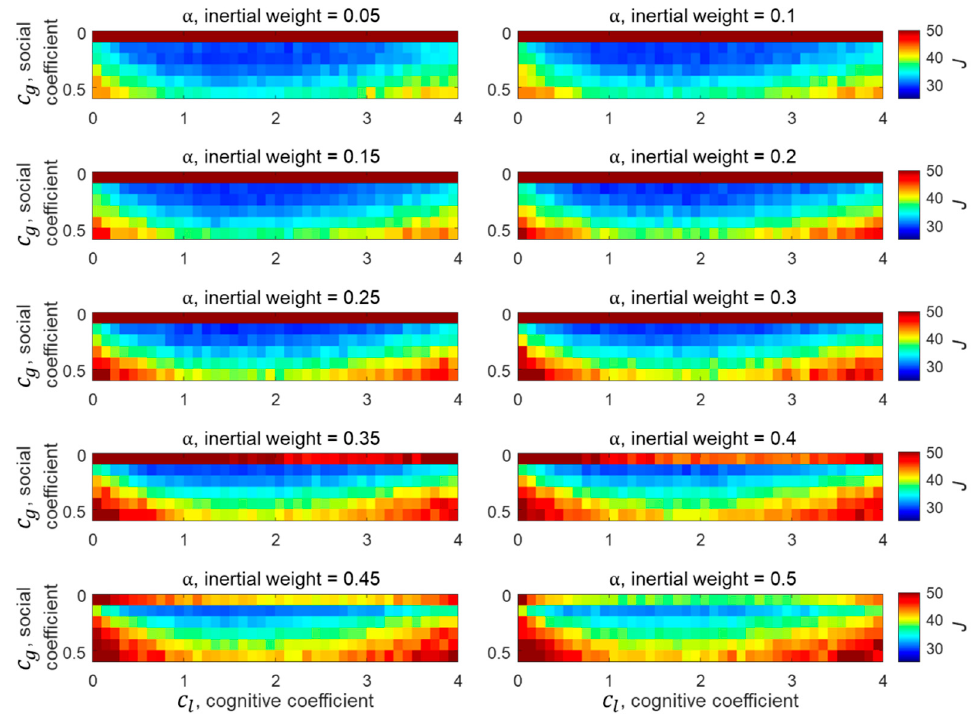
Figure 2. Simulation results for determining the acceleration constants α , 𝑐 (cid:3039) , and 𝑐 (cid:3034) in the final search spaces.